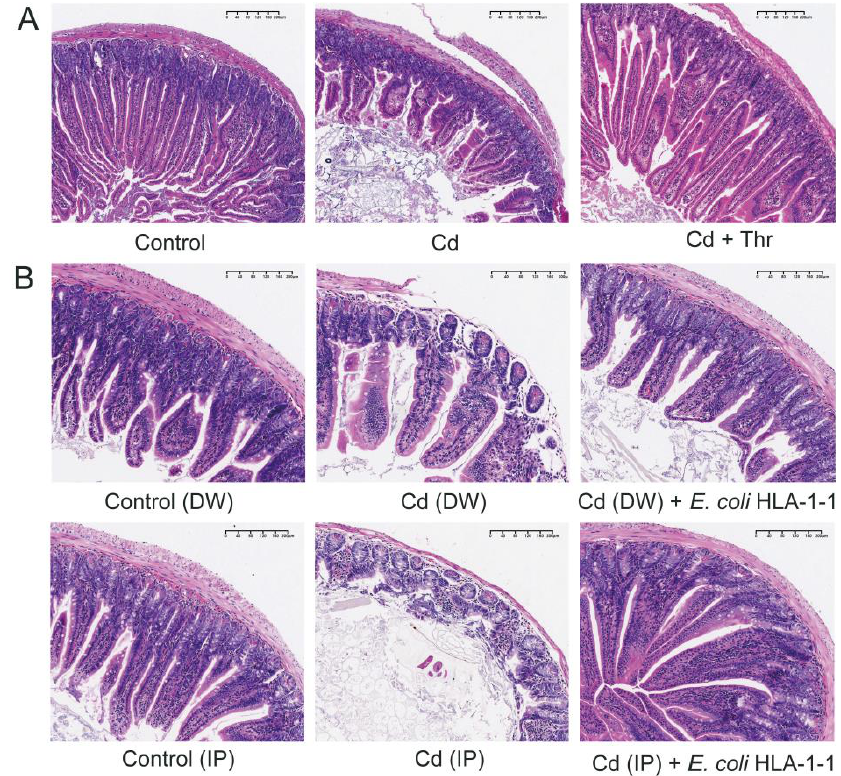
Figure 5. Histopathological changes of the intestine in mice. ( A ) Representative H&E staining pho- tomicrographs of gut sections of mice in control, Cd and Cd + Thr. The magnification of 200 × Bar = 200 μm. ( B ) Representative hematoxylin and eosin staining photomicrographs of gut sections of mice in Control (drinking water, DW), Cd (DW), Cd (DW) + HLA-1-1, Control (intraperitoneal injection, IP), Cd (IP), and Cd (IP) + HLA-1-1 with the magnification of 200 × Bar = 100 μm.